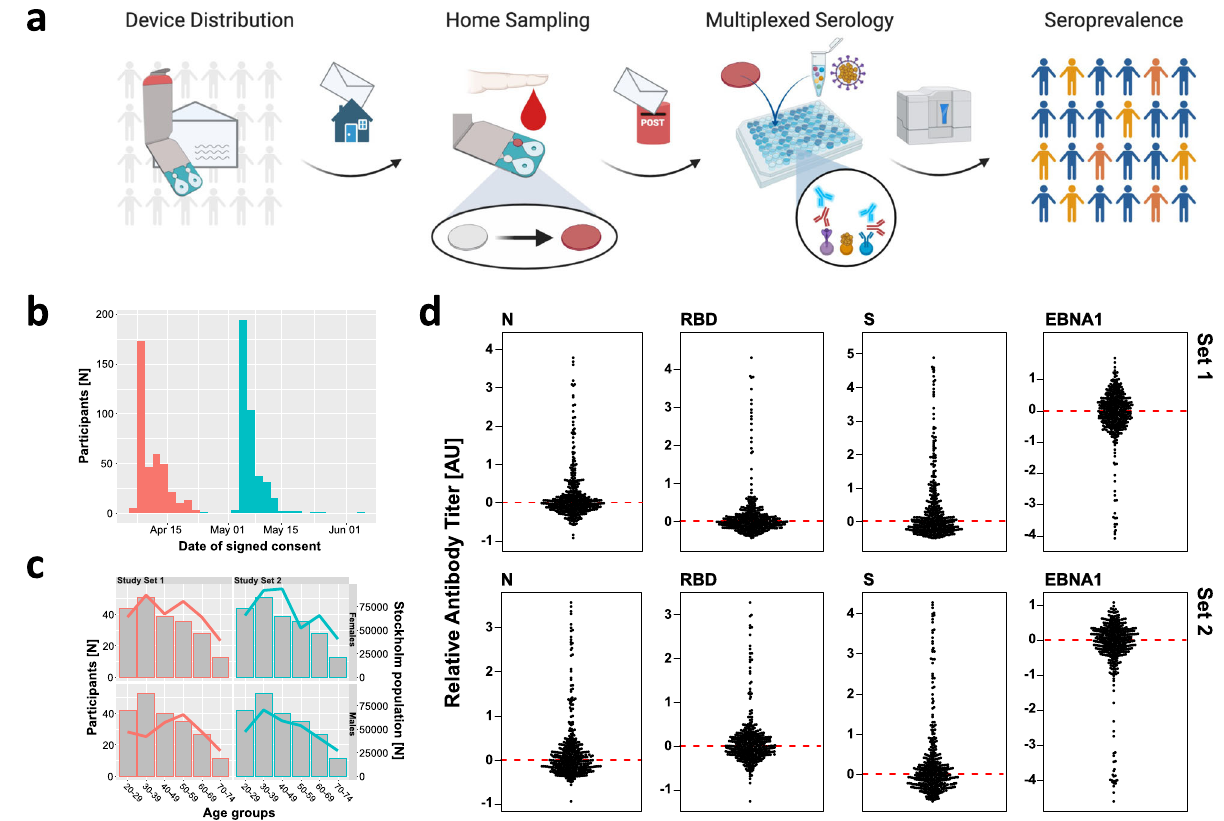
Fig. 1 Translational approach for multiplexed serology in home-sampled dried blood spots. a Blood collection devices were distributed by postal mail to collect blood samples from fi nger pricking at home. Cards were then mailed to the laboratory for multiplexed serological analysis. Data from antibody titers against multiple virus proteins was used to stratify individuals for seroprevalence. b The histogram shows the number of participants ( y- axis) donating blood for the study set 1 (red bars) and set 2 (petrol bars) with inferred date of sampling ( x -axis). c Comparison of sex and age-range demographics between our two study sets (lines) and the Stockholm population statistics (bars). d A panel of the relative IgG antibody levels detected in the two study sets against the SARS-CoV-2 proteins S, RBD, and N as well as EBNA1. The dashed red lines indicate the center of the normalized assay data. Source data are provided as a Source Data fi le.